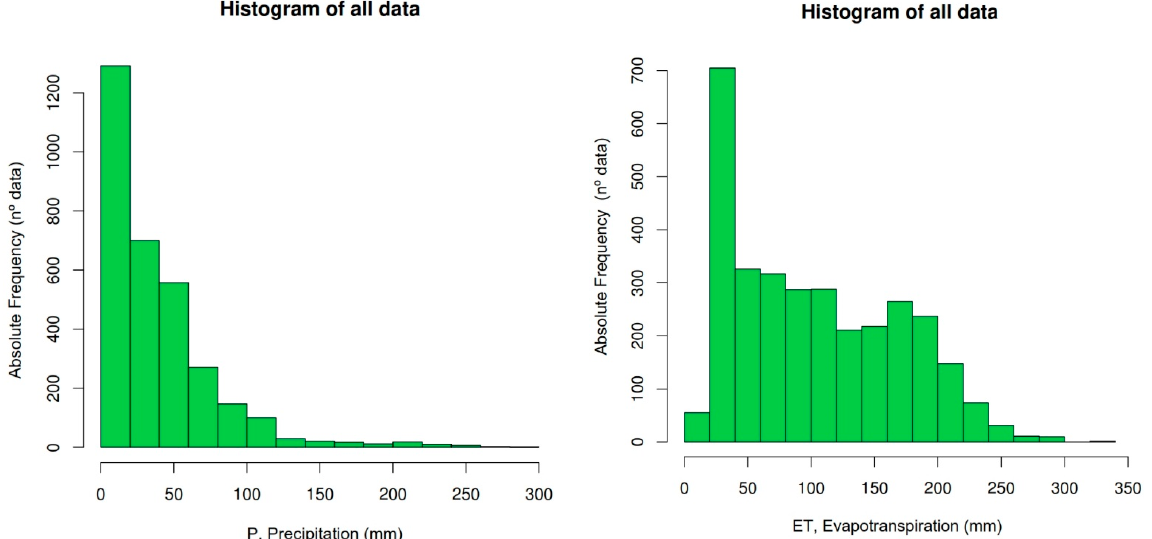
Figure 4. Frequencies of monthly precipitation and evapotranspiration during the period 2006–2020. The annual distribution of ET o and P showed water deficit conditions due to high values of evapotranspiration and low precipitation. Figures 5 and 6 show the monthly results of ET o and Pe. ET o was extremely high in all the studied zones from May to September, where the south ‐ east zone presented the greatest values.